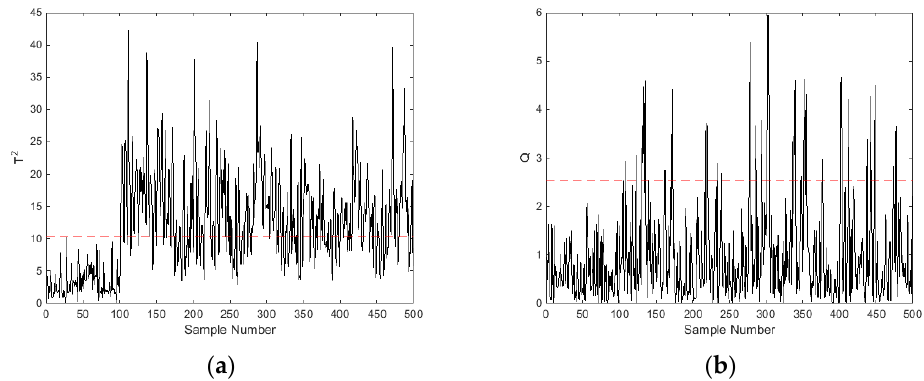
Figure 5. Monitoring charts of oil leakage by using multivariate statistics (50% full load and 1800 rpm): ( a ) Hotelling 2 T at different samples and ( b ) Q statistic at different samples.